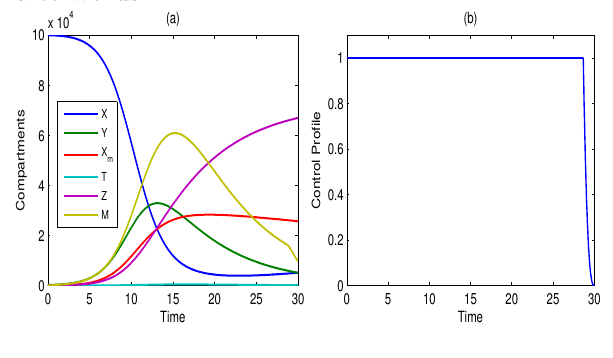
Figure 1. Simulation of determinis- tic model solution ( a ) and control pro- file u ( t )( b ) .